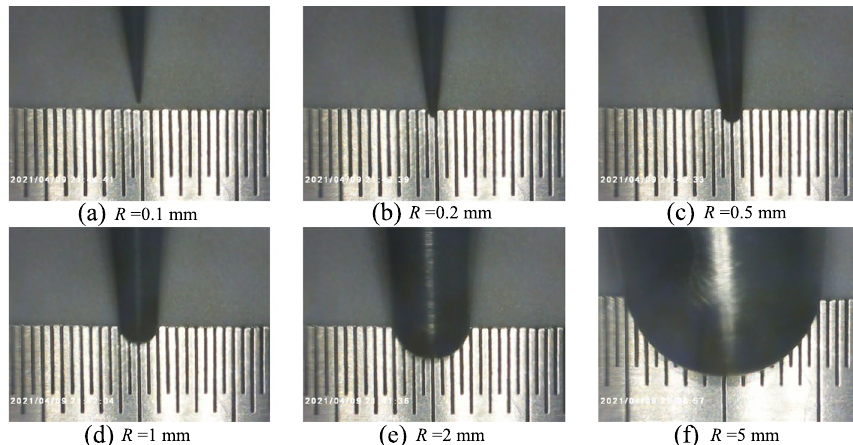
Fig. 3 Cone tip with different bluntness ranging from R